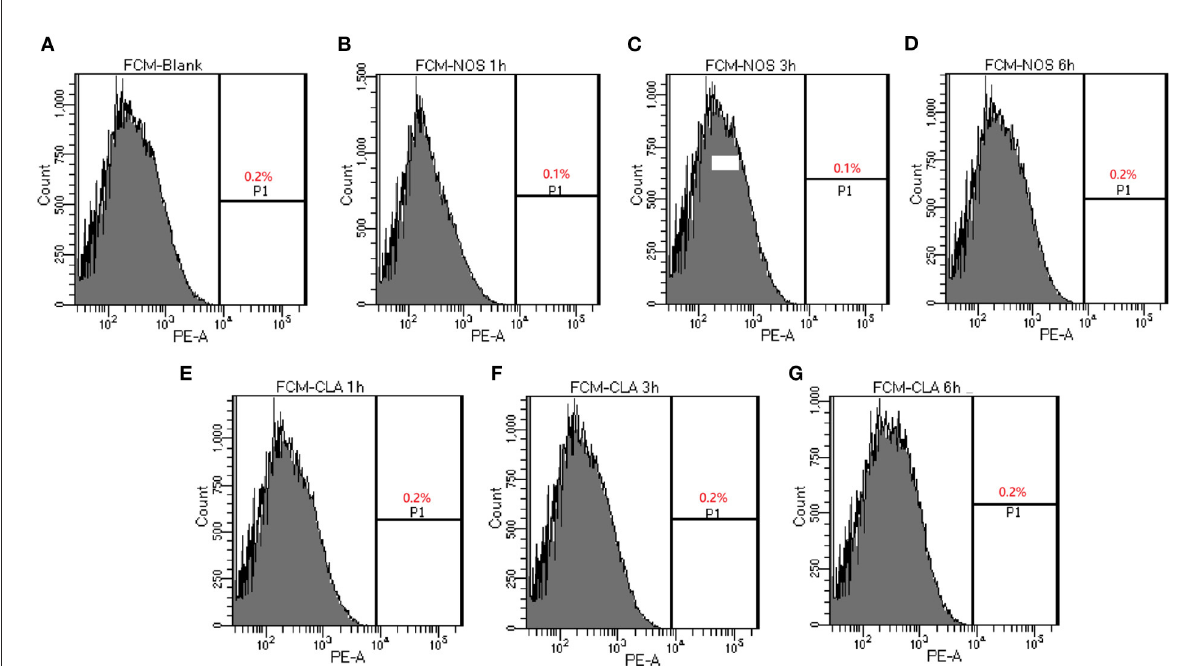
FIGURE2 Determination of membrane-permeabilizing properties of NOS by FCM of M. abscessus ATCC 19977. Bacterial cells are treated with NOS and clarithromycin (CLA) in a time-dependent manner. The percentage of bacterial cells shows the increased uptake of propidium iodide with increasing time intervals. (A) Bacterial cells without treatment serve as a negative control. (B–D) The results after 1, 3, and 6h of treatment with NOS (4 µ g/ml). (E–G) The results after 1, 3, and 6h of treatment with CLA (4 µ g/ml). Samples were prepared in phosphate-buffered saline (PBS).